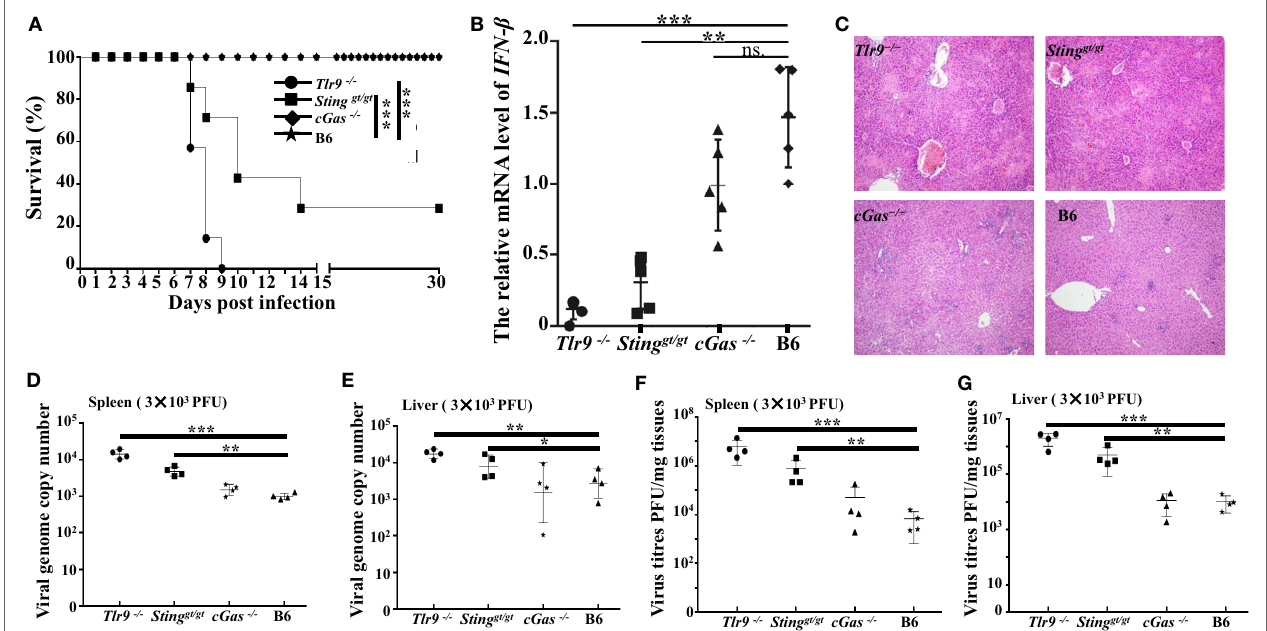
FigUre 7 | Tlr9 and Sting are critical for resistance to ectromelia virus (ECTV) at a low infection dose. Sting gt/gt , cGas − / − , Tlr9 − / − , and wild-type (WT) mice (B6) were infected with 3 × 10 3 plaque-forming units (PFUs) of ECTV in the left footpad. (a) Mice were monitored twice daily over 30 days for survival. (B) The expression of IFN- β in the spleens of the indicated mice at 3 days post-infection (dpi) was examined by qPCR. (c) Liver sections of the indicated mice at 7 dpi were stained with hematoxylin and eosin. (D–g) The spleen and liver from infected mice were harvested at 7 dpi, and then the viral genome copy numbers (D , e) and viral loads (F , g) were determined by qPCR and plaque assay, respectively. Statistical analyses were performed by one-way analysis of variance followed by the Duncan’s multiple range test. For survival experiments, we used the log-rank (Mantel–Cox). In this figure, ns, not significant; * P ≤ 0.05; ** P ≤ 0.01; and *** P ≤